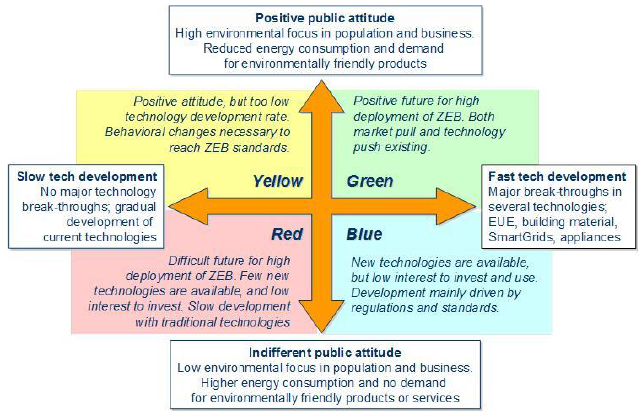
Fig. 2.Overview of the four